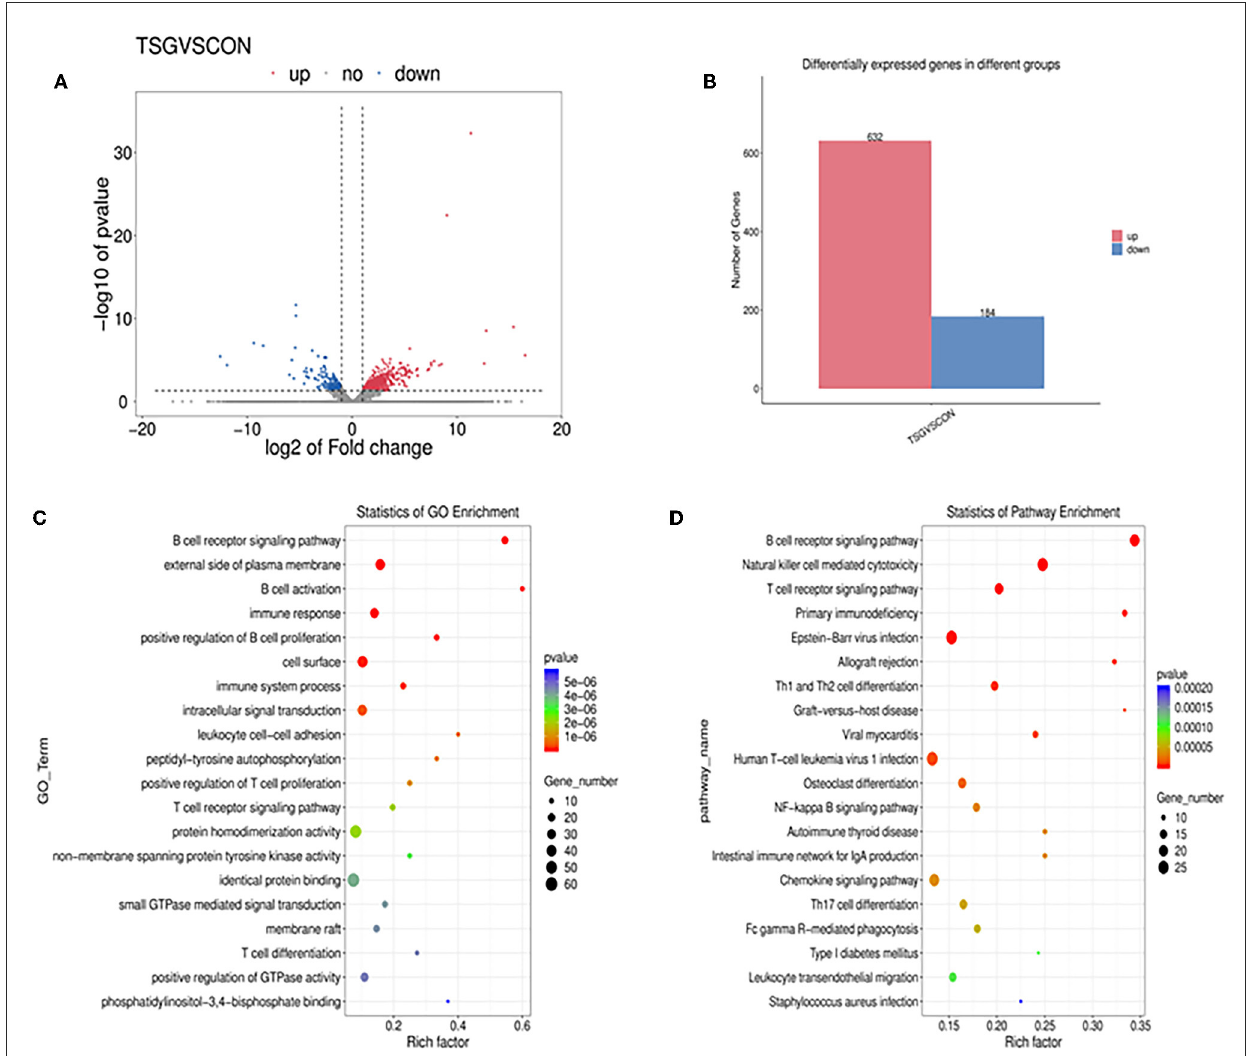
FIGURE5 The results of the transcriptomics profiling technique. (A) A volcano plot of all genes differentially expressed. Red represents significantly upregulated genes, blue represents significantly down-regulated genes, and gray dots represent non-significantly differentially expressed genes. (B) Histogram of the number of differentially expressed genes between the transport stress group and the control group. Genes that are upregulated in red and downregulated in blue. (C) GO terms scatter plot of GO terms enrichment in the top 20 pathways and (D) KEGG pathway analysis of DEGs in the top 20 pathways. The X-axis represents the degree of enrichment. In the scatter diagram, the size of the dot represents the gene number and the color of the dot represents the P -value of enrichment analysis.